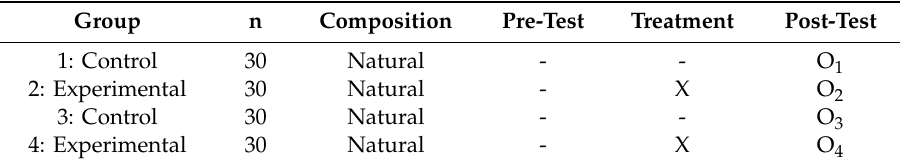
Table 1. Research